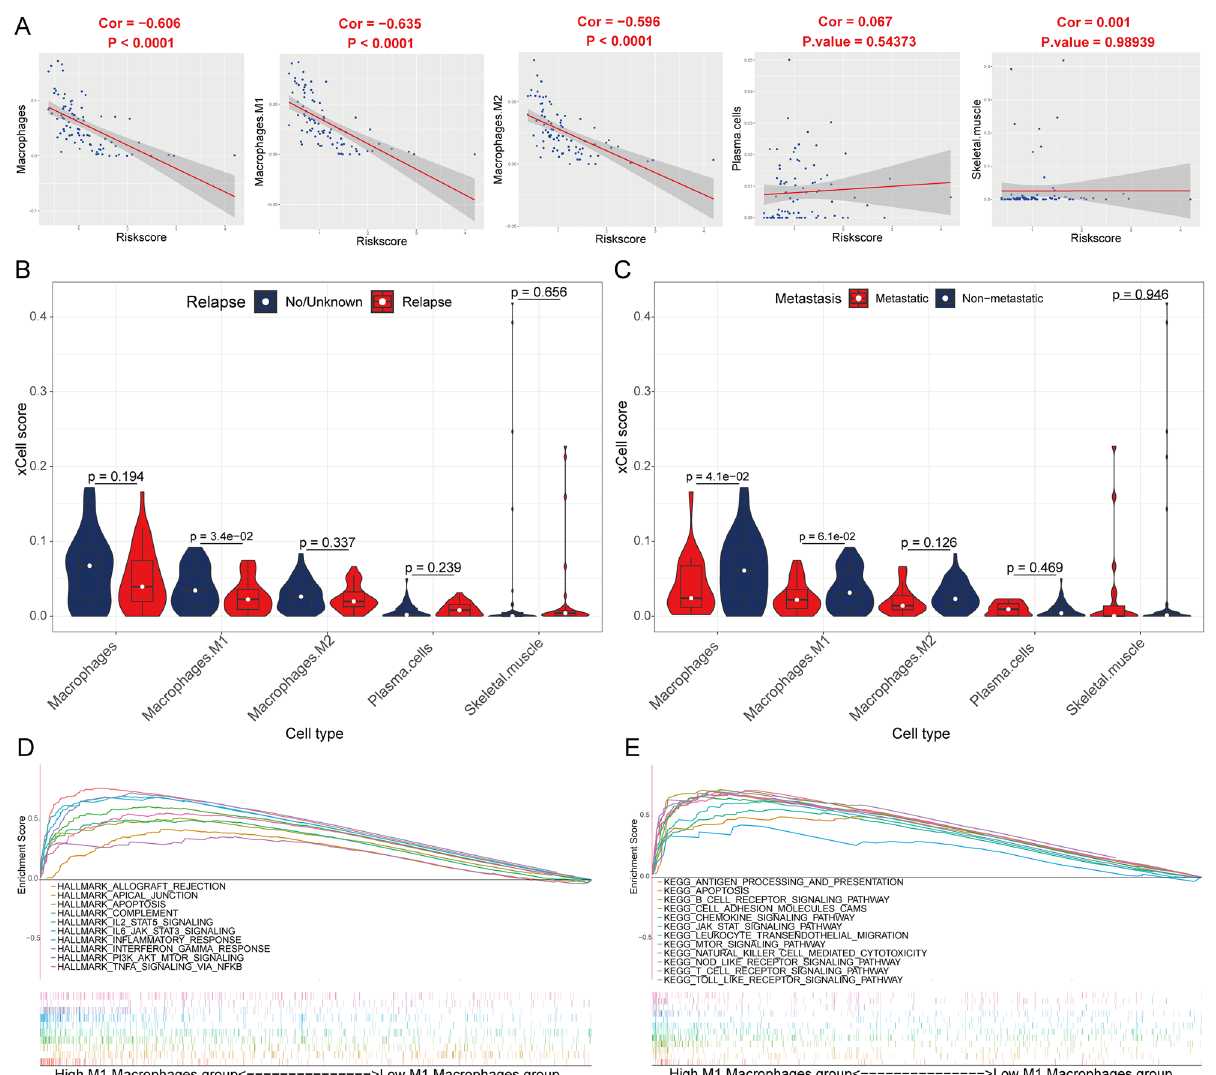
Figure 5. The correlation of risk score with xCell score. ( A ) The correlation between the risk score and xCell score in the TCGA cohort. ( B , C ) Comparison of xCell score of the five prognostic related immune cells between relapse/metastatic and non-relapse/non-metastatic group in the TCGA cohort. GSEA in the Hallmarks ( D ) and KEGG ( E ) gene set between group high (n = 42) and low (n = 42) of M1 macrophages in the TCGA